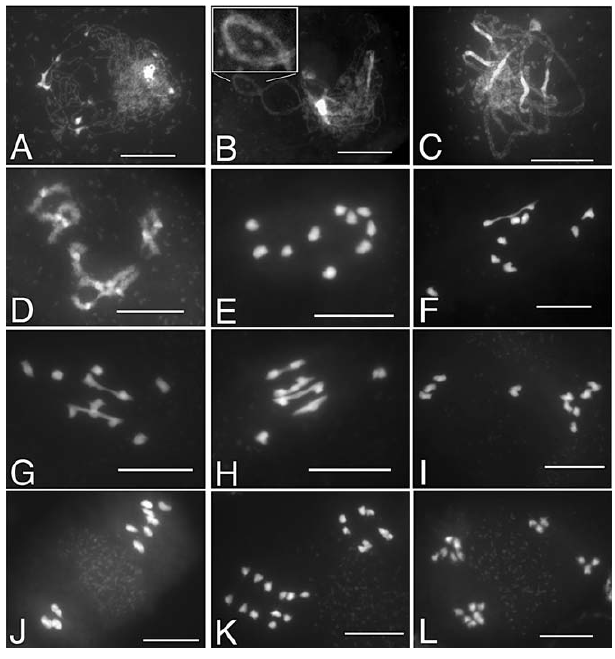
Figure 4. DAPI Staining of Atzip4-1 PMCs during Meiosis (A) Leptotene, (B) zygotene: The synapsed portion of (B) has been magnified and is presented in the boxed area of the figure. (C) Pachytene, (D) diakinesis, (E–H) metaphase I, (I) anaphase I, (J) metaphase II, (K) anaphase II, (L) end of meiosis. Bar, 10 l m.